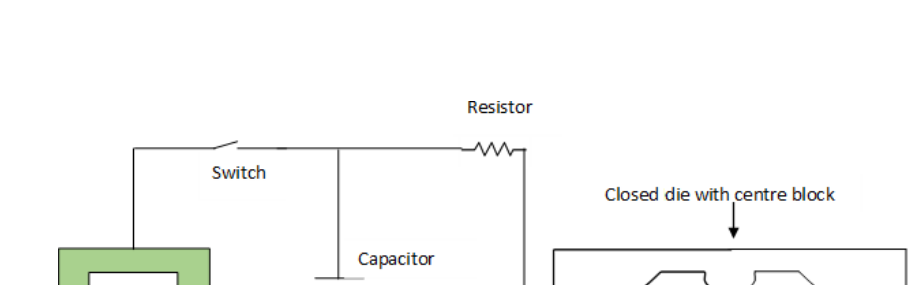
Figure 4. Flowchart of the finite-element method.